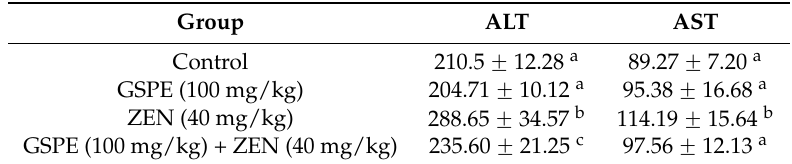
Table 1. Effect of grape-seed proanthocyanidin extract (GSPE) on zearalenone (ZEN)-induced hepatic damage by testing the serum activities of ALT and AST in mice.